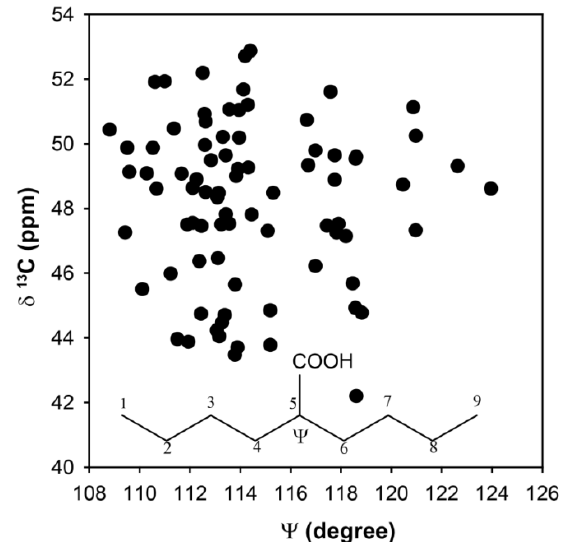
Figure 4. Predicted 13 C-NMR chemical shift variation for the methine (CH) carbon as a function of the bond angle Ψ